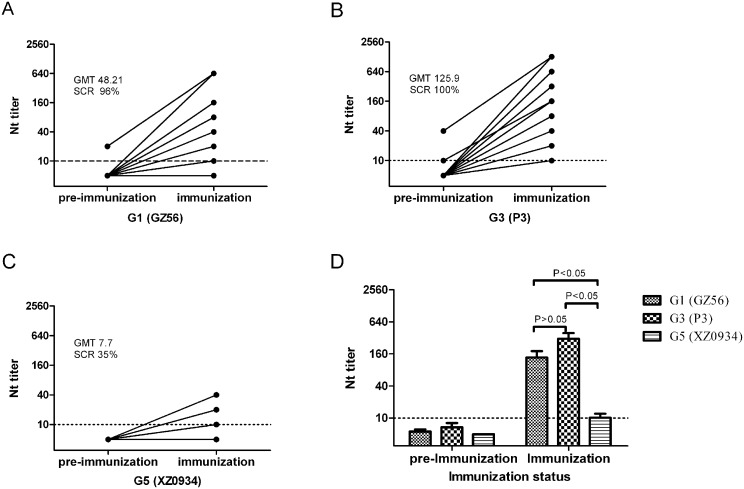
SA14-14-2 JE LAV–induced immune response in two-year-old children 28 days before and after vaccination.PRNT90 titers against viral strains of different JEV genotypes are shown before and 28 days after a vaccination: (A) G1 JEV (GZ56 strain), (B) G3 JEV (P3 strain) and (C) G5 JEV (XZ0934 strain). (D) end-point PRNT90 titers against three genotypes JEV antibodies were assayed. The gray lines indicate PRNT90 titer = 1:10. PRNT90 titers of ≥1:10 were considered protective. The seroconversion rates (SCRs) and geometric mean titers (GMTs) are given in each panel. P < 0.05 showed statistically significant.